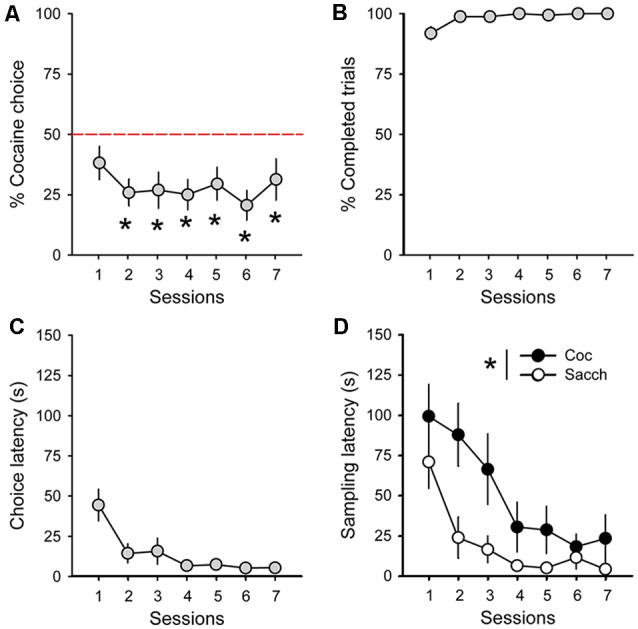
Rats prefer saccharin over cocaine. (A) Mean (±SEM) percentage of cocaine choice across sessions. The red dotted line represents the indifference level. *p < 0.05 against indifference. (B) Mean (±SEM) percentage of completed trials across choice sessions. (C) Mean (±SEM) choice latency across choice sessions. (D) Mean (±SEM) cocaine (black circles) and saccharin (white circles) sampling latency across choice sessions. *p < 0.05 compared to saccharin.